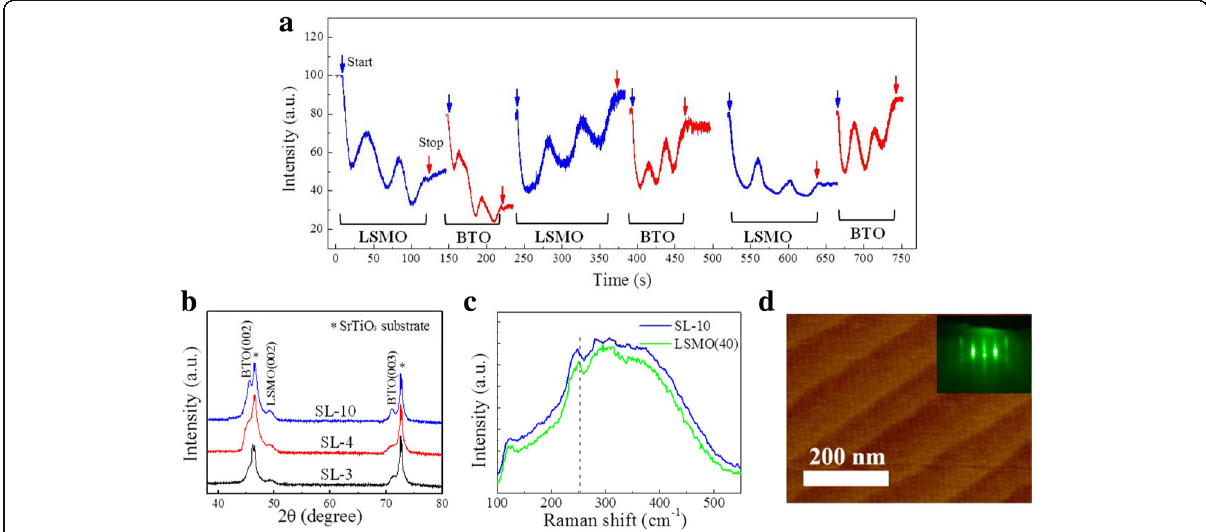
Fig. 1 a RHEED intensity oscillations for the growth of the SL-3 sample. b XRD patterns for three different SL-n samples ( n = 3, 4, 10). c Raman spectra for the SL-10 and LSMO(40) samples measured at 300 K. d AFM image of a BHF-etched, bare (001) SrTiO 3 substrate. The inset shows the RHEED diffraction pattern of the SL-3